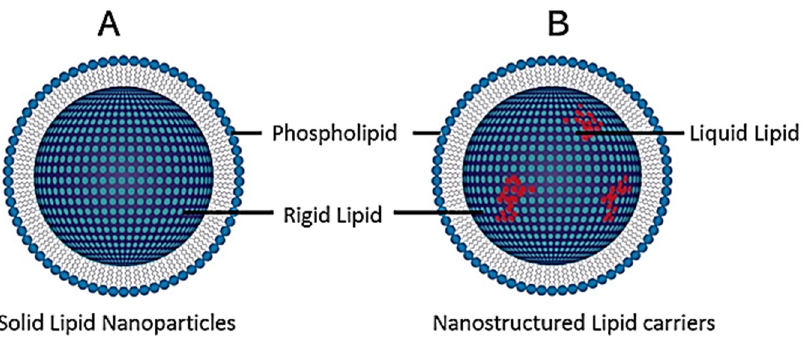
Figure 4. General structure of ( A ) solid lipid nanoparticles (SLNPs) and ( B ) nanostructured lipid carriers (NLCs).